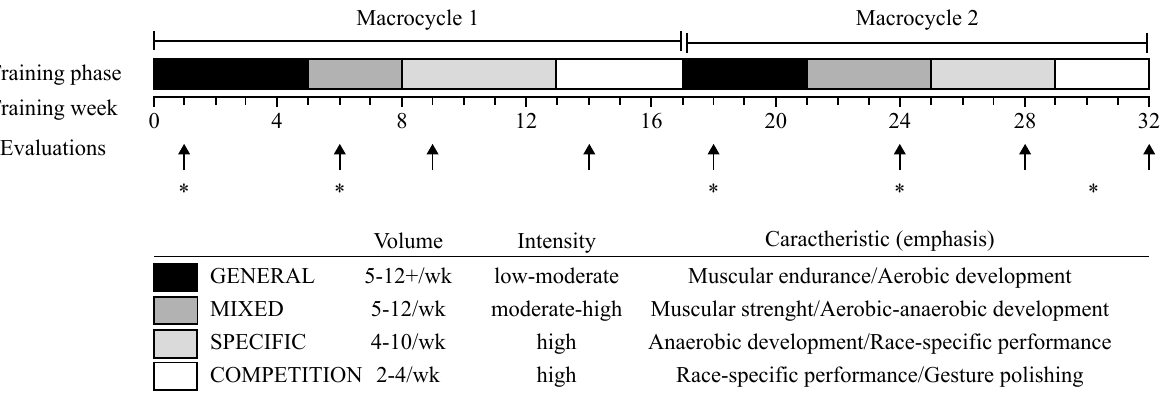
Figure 1. Summary of study design. The black arrows (↑) indicate the assessments of dietary consumption and energy expenditure. The asterisks (*) indicate body composition